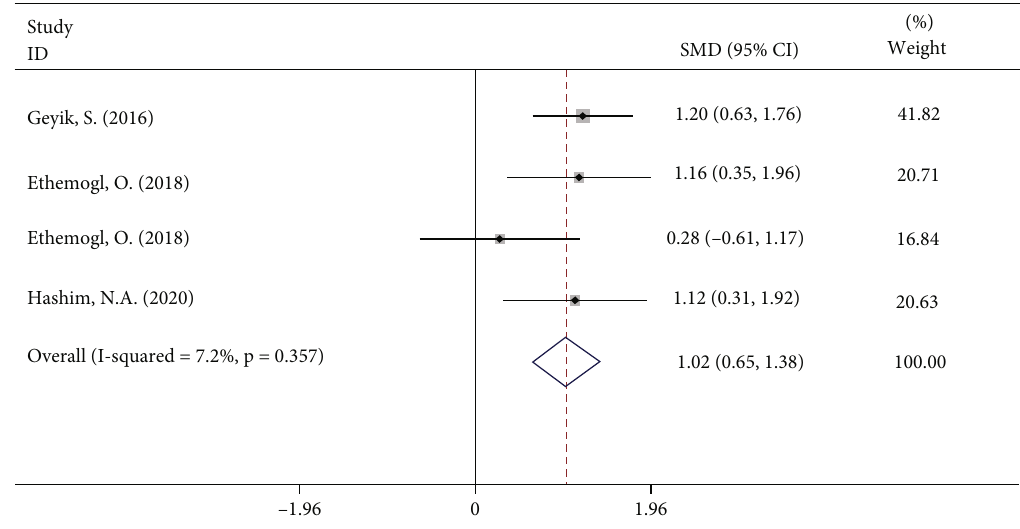
Figure 8: Meta-analysis of di ff erences in NLR levels between GBS patients with good and bad